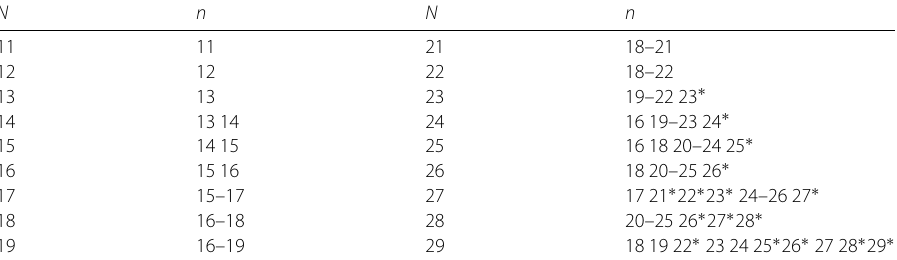
Table 6 The presence of delinquent eigenvalues of U n in the case of a discrete weight function N n N